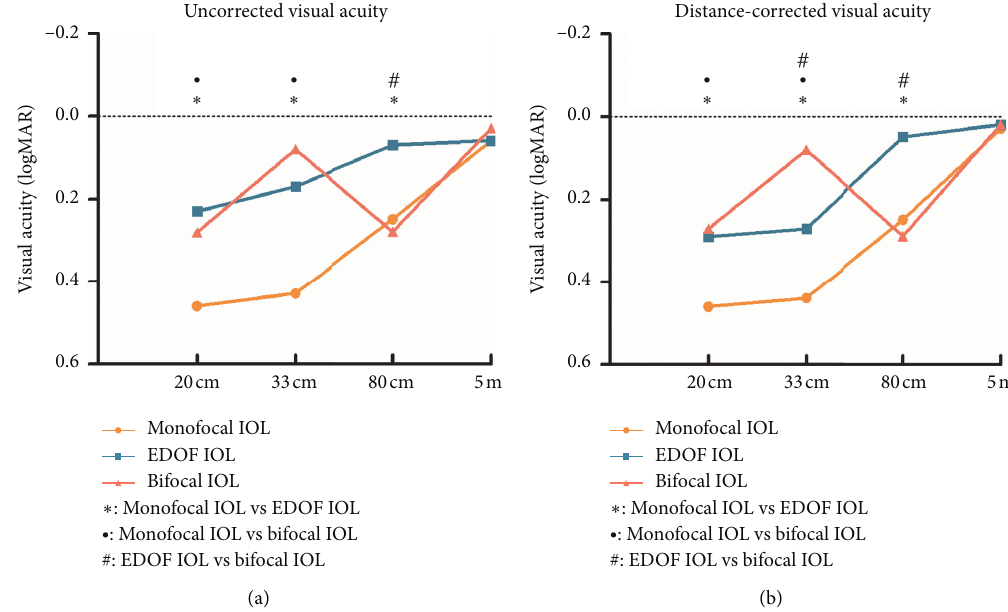
Figure 1: Comparison of the mean visual acuity at all distances among the 3 intraocular lens (IOL) groups ( ∗ � statistically significant difference between the monofocal group and the extended range of vision (EDOF) group [ P < 0 . 05 ] ; ● � statistically significant difference between the monofocal group and the bifocal group [ P < 0 . 05 ] ; # � statistically significant difference between the EDOF group and the bifocal group [ P < 0 . 05 ] ; logMAR � logarithm of minimum angle of resolution).